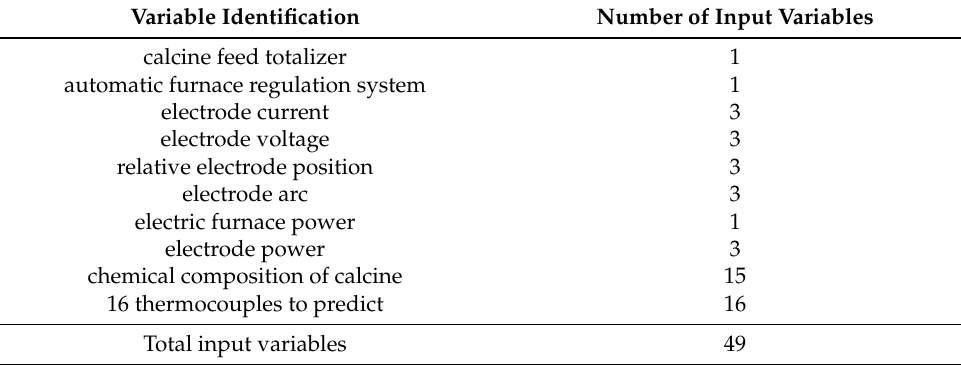
Figure 5. General steps in the temperature prediction methodology. Table 1. Description of input